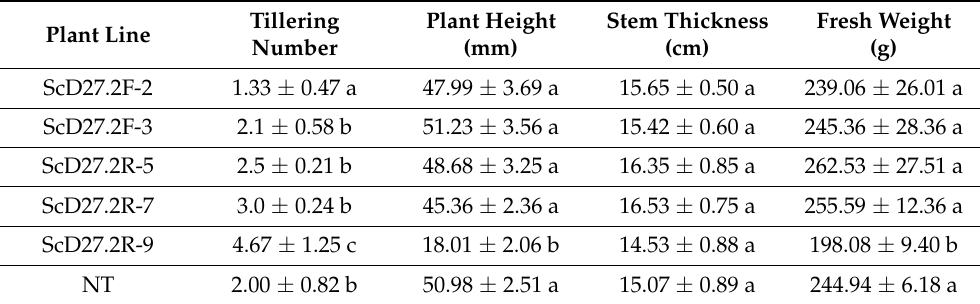
Table 2. Phenotypic analysis of ScD27.2 sense overexpression and ScD27.2R-9 antisense interference transgenic lines.